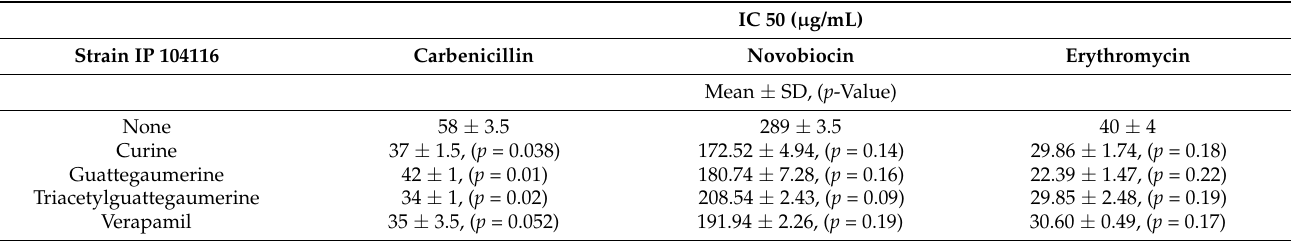
Table 1. IC50 of P. aeruginosa IP104116 for carbenicillin, novobiocin, and erythromycin in the presence or absence of alkaloids. IC 50 ( µ g/mL)